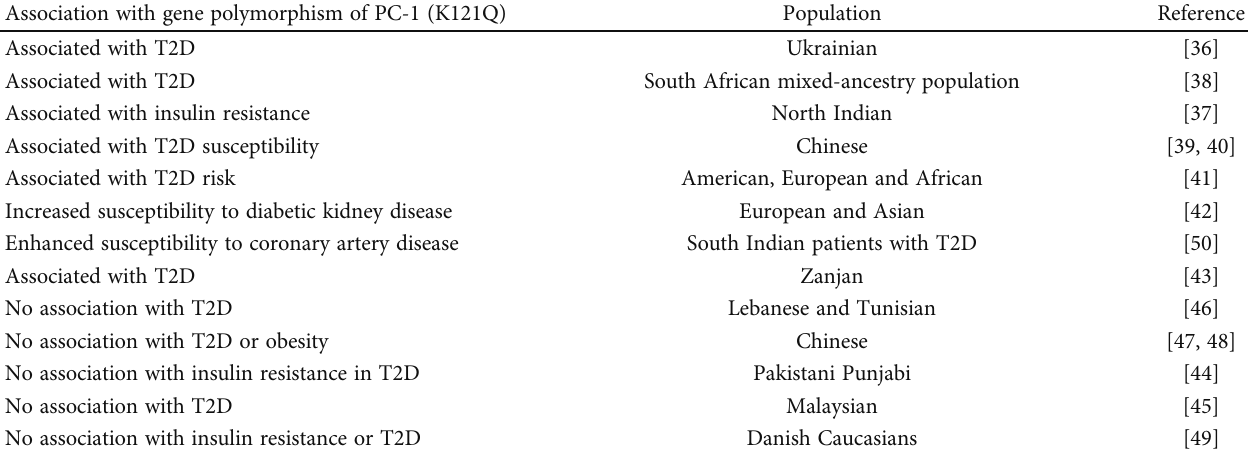
Table 1: Association with gene polymorphism of PC-1 (K121Q) with insulin resistance or T2D in various populations. Association with gene polymorphism of PC-1